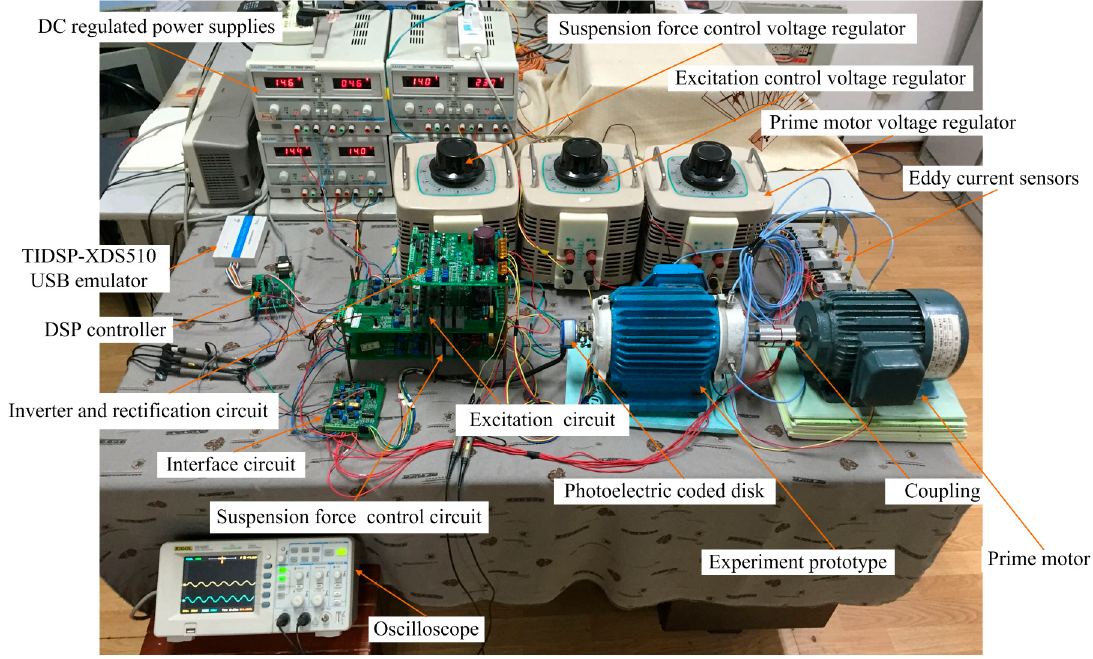
Figure 13. The experimental results based on compensation control strategy of flux ‐ linkage